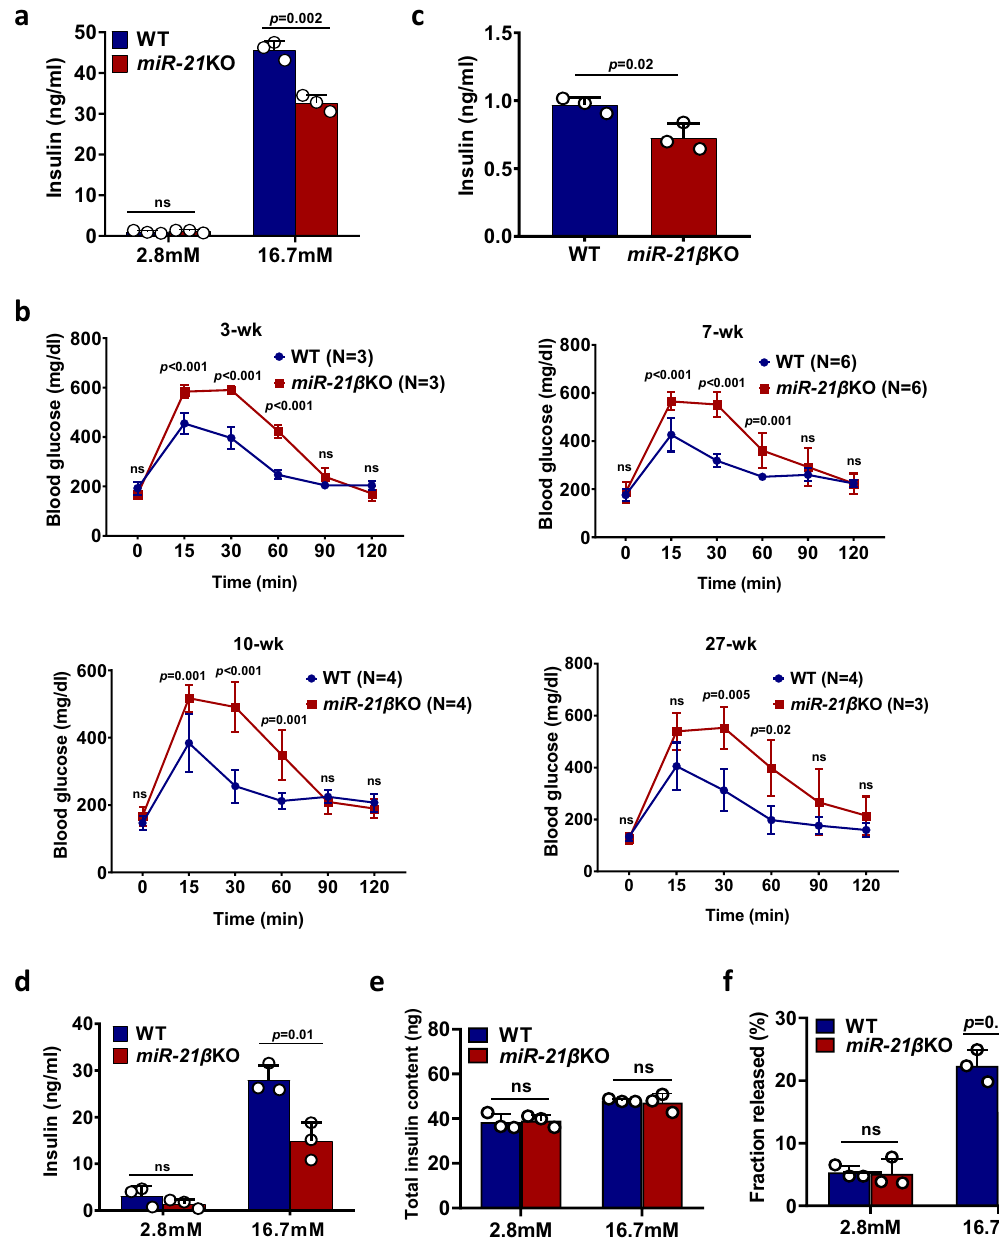
Fig. 2 Mice with pancreatic β cell speci fi c deletion of miR-21 display impaired blood glucose tolerance and insulin secretion. a Pancreatic islets from 8-week-old WT and conventional miR-21 KO mice ( n = 3) were treated with 2.8 mM or 16.7 mM glucose. Insulin level in the culture supernatant was determined by ELISA. Data are presented as means ± SD for n = 3 biologically independent samples. b 3-, 7-, 10- and 27-week old wild type (WT) and conditional miR-21 β KO mice were fasted for 4 h before treated with 2 g/kg body weight D -glucose. Blood glucose level was measured at the indicated time- points. Data are presented as means ± SD for multiple biologically independent mice (as indicated in the fi gure). Statistical signi fi cance was analyzed using two-way ANOVA and P values are indicated in the fi gure. c 7-week-old WT and miR-21 β KO mice ( n = 3) were treated as in (b) for 30 min. Serum was obtained from tail vein and insulin level was measured. Data are presented as means ± SD for n = 3 biologically independent samples. d – f Pancreatic islets from 7 — 8-week old WT and miR-21 β KO mice ( n = 3) were treated with 2.8 mM and 16.7 mM glucose. Insulin level in the supernatant was measured ( d ). Alternatively, total islet insulin content ( e ) and fractional insulin release ( f ) from islets treated with 2.8 mM and 16.7 mM glucose were determined by ELISA. Data are presented as means ± SD for n = 3 biologically independent samples. All statistical signi fi cance analysis except ( b ) was performed using two-sided unpaired t test and P values are indicated in the fi gure. All panels except ( b ) are representative of at least two independent experiments. Equal numbers of male and female mice were used in two genotypes. ns: not signi fi cant. Source data are provided as a Source Data fi Islets from miR-21 β KO mice exhibit impaired glucose uptake . TFPI-regulating protein (Adtrp), no other genes exhibit a signi fi cant difference in Ago2-immunoprecipitated RNAs from To further determine which speci fi c pathway was affected by MIN6 cells transfected with negative control and miR-21 miR-21 de fi ciency, we fi rst examined insulin secretion evoked antagomir (Fig. S8b). by high K + , an experimental paradigm that bypasses glucose